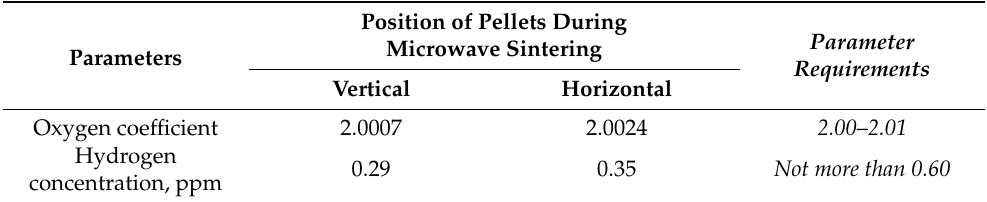
Figure 7. Photo microstructure of pellet obtained by sintering in horizontal position (1600 °C, 120 min), at different magnifications: ( a ) grain of pellet, 500×; ( b ) porosity of pellet, 10×. The data on the oxygen and hydrogen content in the pellets obtained in the vertical and horizontal position in the microwave resonator of the oven are shown in Table 1. As can be seen from the above data, the oxygen ratio was not more than 2.0024, and the mass fraction of hydrogen was about 0.30 ppm. Table 1. Oxygen coefficient and hydrogen content in pellets obtained in vertical and horizontal position during microwave sintering.